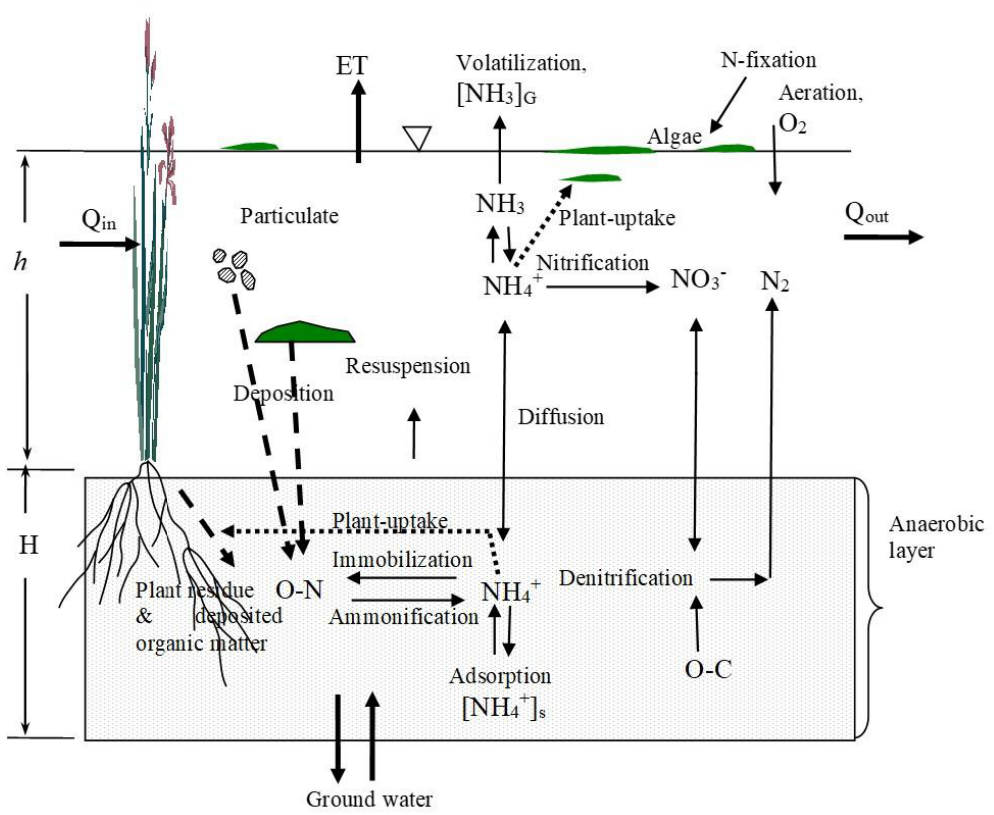
Figure 2. Schematic diagram of nitrogen processes in wetlands: water column and soil layer: Figure modified and reproduced from Hantush, et al. [11].